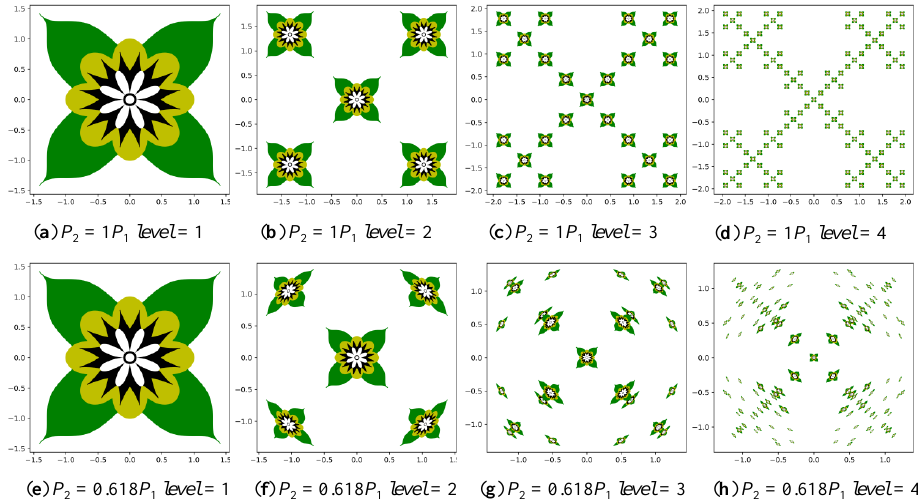
Figure 9. Layout patterns generated by setting parameters P 2 = 1 P 1 and 0.618 P 1 and level = 1, 2, 3, and 4.